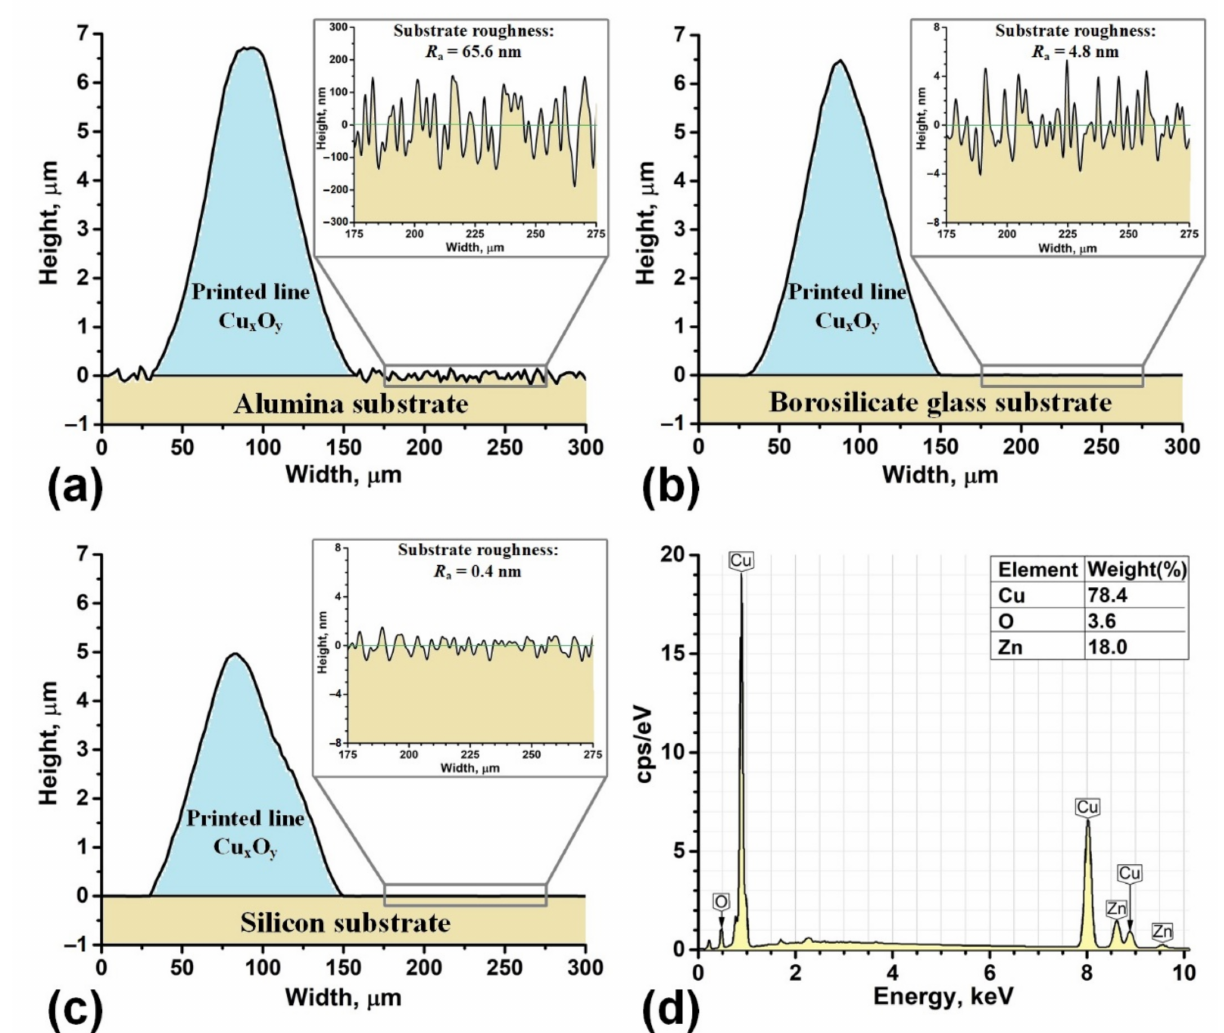
Figure 3. Cross-sectional profiles of printed lines from nanoparticle formed on substrates of ( a ) alumina, ( b ) borosilicate glass, and ( c ) silicon, ( d ) typical energy-dispersive X-ray spectroscopy EDX-spectrum of presented lines measured by SEM